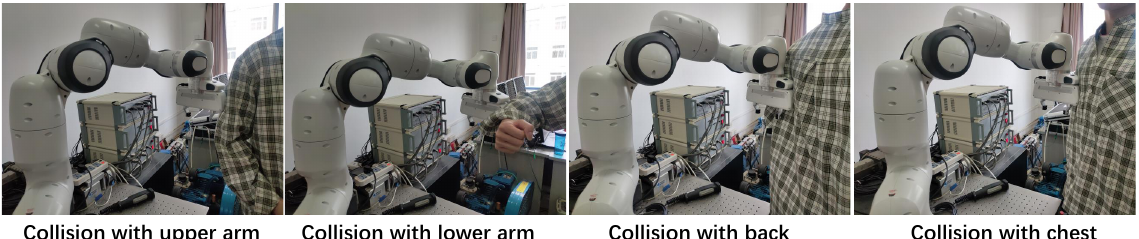
Figure 16. Human–computer interaction crash test with different body